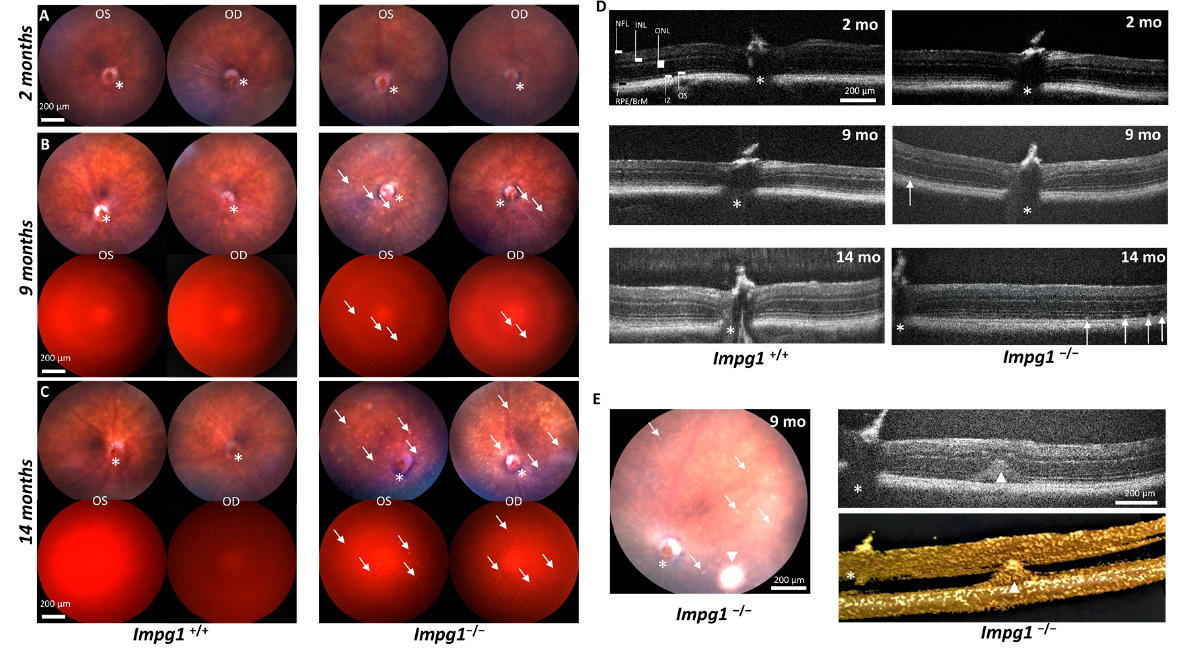
Figure 2. Impg1 − / − mice develop autofluorescent subretinal deposits. ( A ) No defects were observed in the fundus of young mice of 2 months of age. Asterisks indicate the optic nerve ( n = 10). ( B ) Fundus examination showed numerous retinal hypopigmented deposits (arrows) from 9 months of age, some of which are autofluorescent (excitation range is 444.5–564.5 nm and emission range > 568 nm). Asterisks indicate the optic nerve ( n = 10). ( C ) Fundus examination of 14-month-old mice. Retinal deposits (arrows) increase in number and autofluorescence with age ( n = 10). ( D ) SD-OCT localized these hyper-reflective clusters between the photoreceptor OS and the RPE. Ten wild-type mice and 10 Impg1 − / − mice were examined, and all 9-month and 14-month-old mutant mice had similar clusters (white arrows) scattered all over the retina, which were not present in wild-type mice (top, left-hand panel). ( E ) Funduscopy and SD-OCT imaging of an Impg1 − / − retina with a large localized autofluorescence nummular clumping (arrowheads). Lower right panel shows 3D reconstitution. NFL, nerve fiber layer; INL, inner nuclear layer; ONL, outer nuclear layer; RPE, retinal pigment epithelium; BrM, Bruch’s membrane; IZ, interdigitation zone; OS, outer segment.